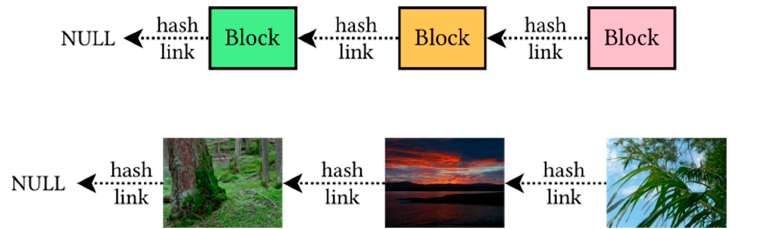
Figure 1. The comparison of the blockchain ( top ) and imagechain ( bottom ). In the imagechain, blocks are embedded in the images so that the pictures are directly linked to each other.